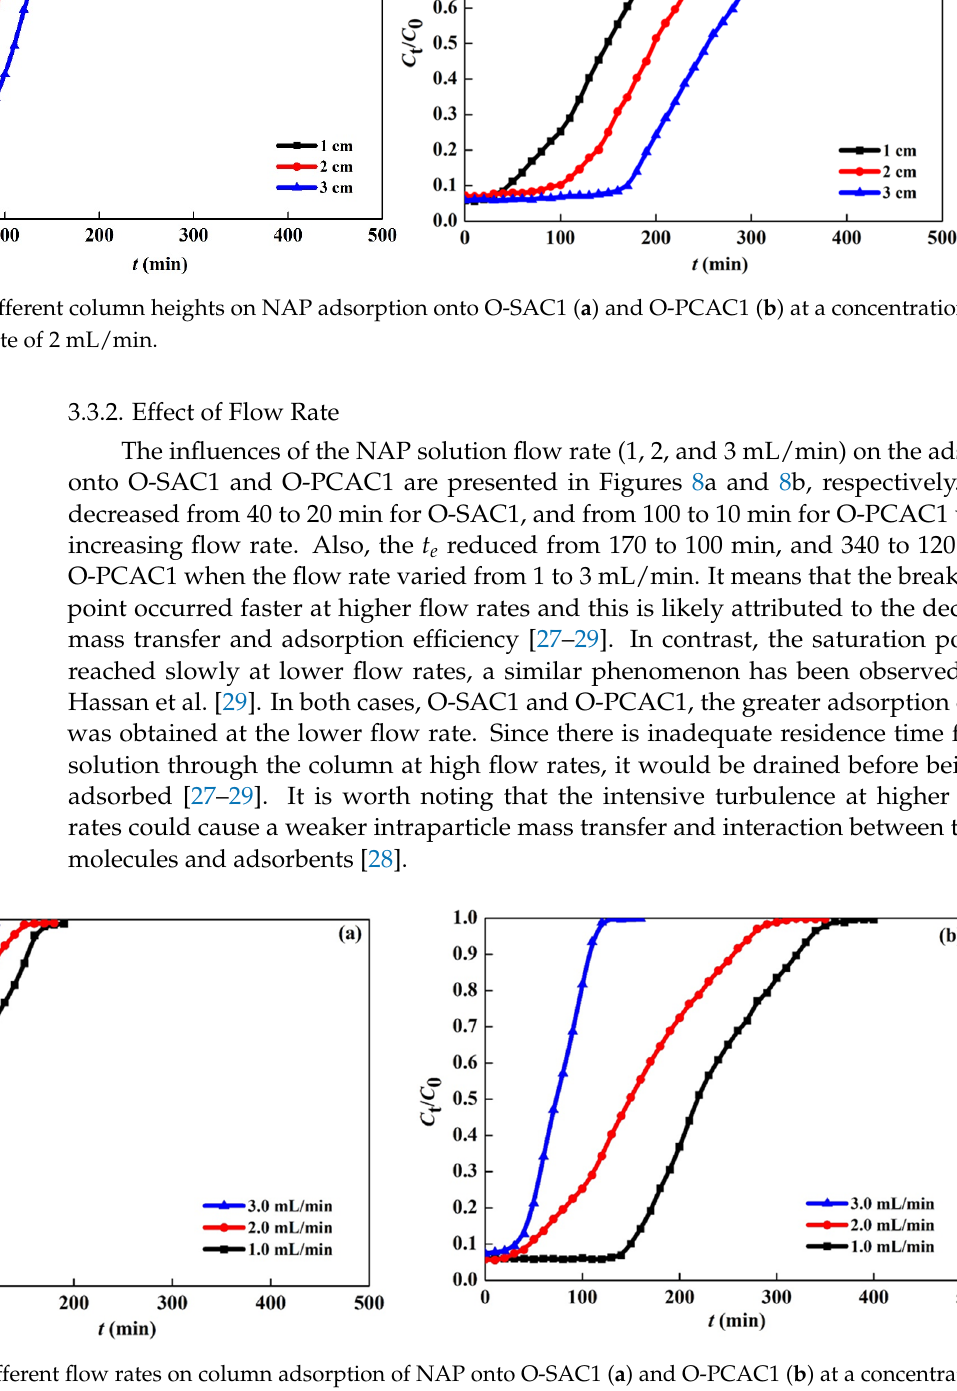
Figure 8. Effect of different flow rates on column adsorption of NAP onto O-SAC1 (a) and O-PCAC1 (b) at a concentration of 30 mg/L and column height of 1 cm.